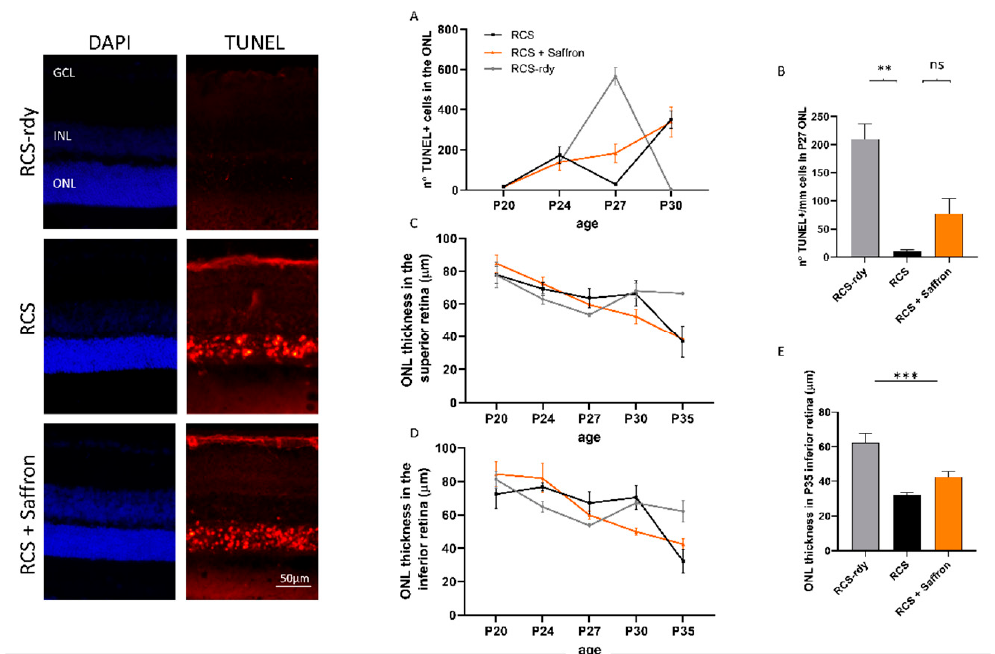
Figure 2. Impact of the Royal College of Surgeons Rat (RCS) Saffron treatment on TUNEL-positive cells in the outer nuclear layer (ONL) during retinal development. Representative pictures of nuclei-stained retinal layers (DAPI) and dying photoreceptors (TUNEL technique) at P30. ( A ) TUNEL+ cell count at different developmental stages ( B ) TUNEL+ cell count at P27. ( C , D ) Means of ONL thickness at different developmental stages in superior and inferior retina, respectively. ( E ) Bar graph of ONL thickness at P35 in inferior retina. ( n = 4; ±SEM; Statistical tests: two-way ANOVA followed by Dunnett’s test) significance indicator: n.s. p > 0.05; ** p < 0.01; *** p < 0.001.